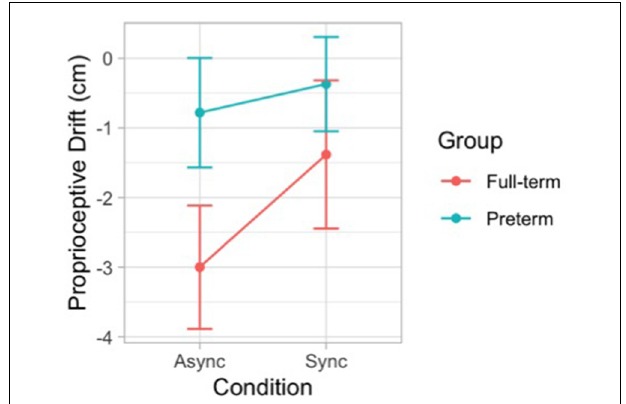
FIGURE 5 | Error bar graph of the mean proprioceptive drift following synchronous and asynchronous visuotactile stimulation in full-term (red) and preterm (blue) children. The graph shows the interaction effect between visual-tactile condition and group.